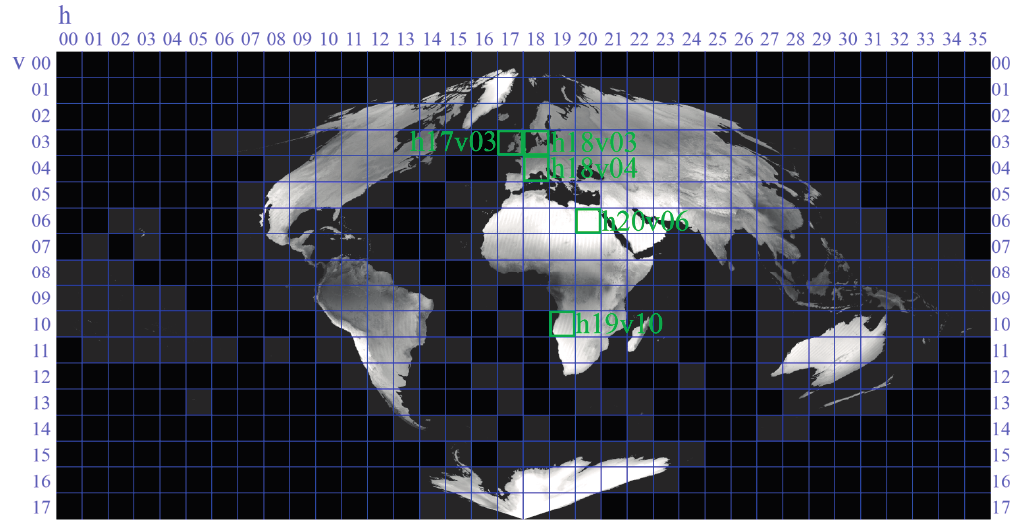
Figure 1. Tiles and projection of MODIS land products. Tiles selected as examples for this study are